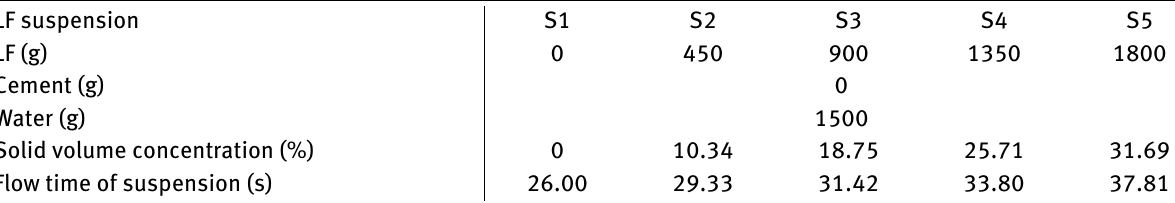
Table 5: Composition and designation of the suspension of limestone